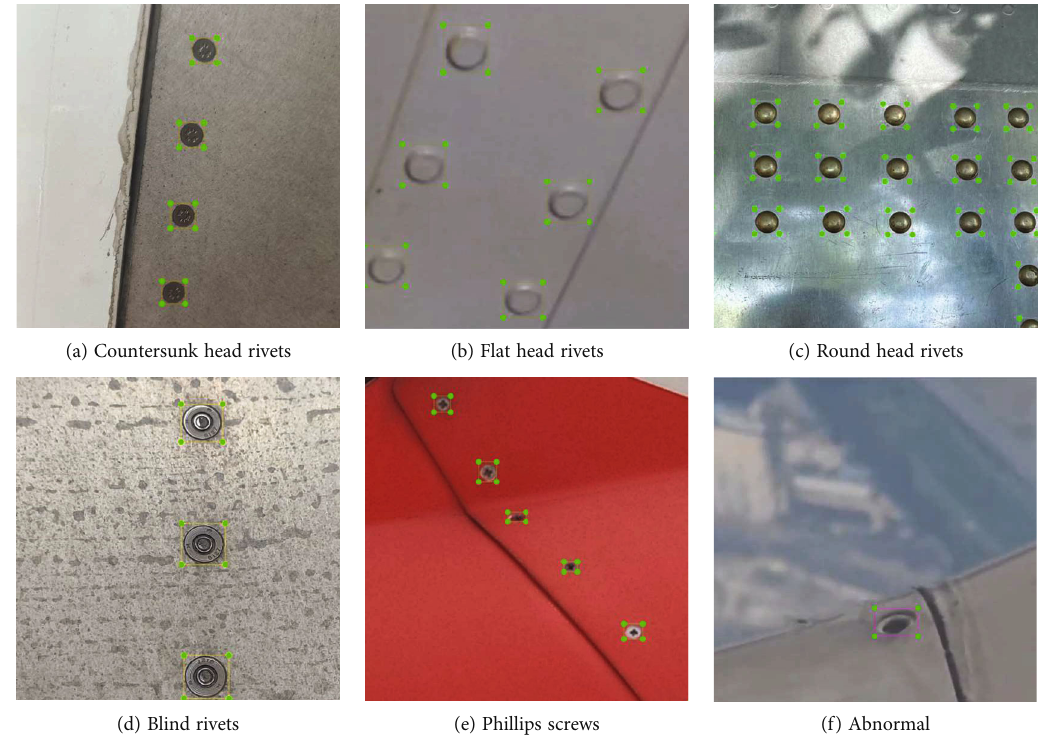
Figure 3: Marking results of di ff erent types of rivets.